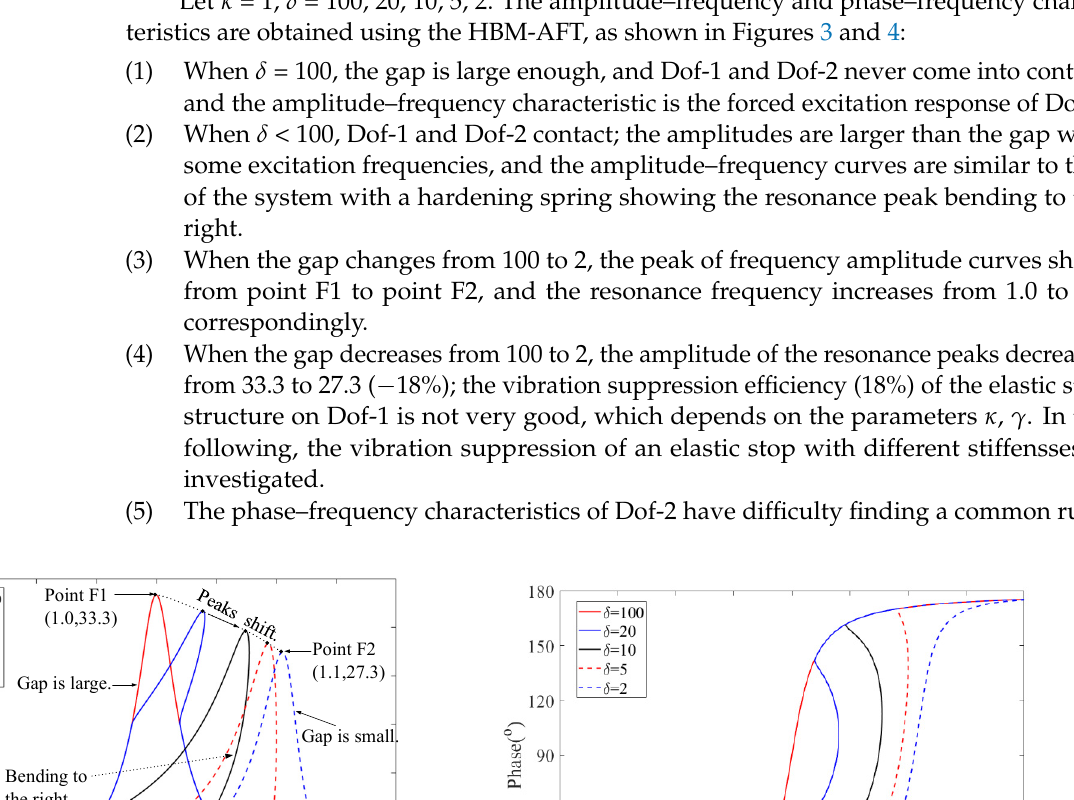
Figure 4. Amplitude–frequency characteristics and phase–frequency characteristics of Dof-2 in the system with different gaps: ( a ) amplitude–frequency characteristics; ( b ) phase–frequency character- istics.